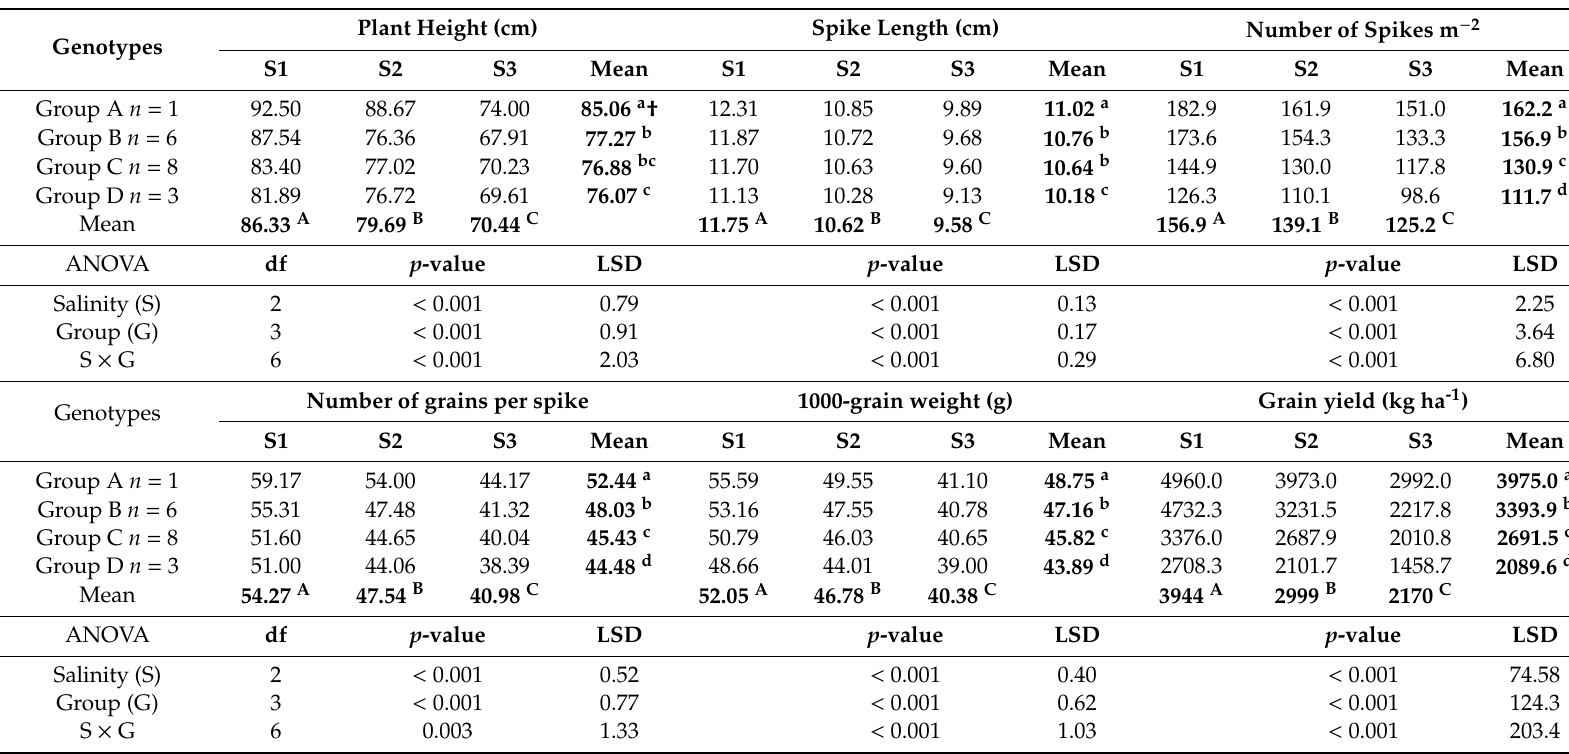
Table 5. Impact of di ff erent salinity levels on plant height, spike length, number of spikes per square meter, number of grains per spike, 1000-grain weight, and grain yield of four genotype groups classified according to salinity tolerance under three salinity levels of S1 (5.25 dS m − 1 ), S2 (8.35 dS m − 1 ), and S3 (11.12 dS m − 1